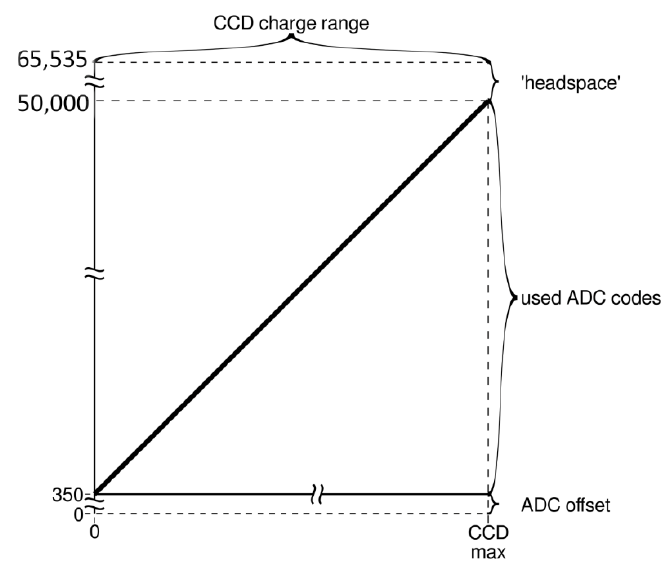
Figure 3. Diagram showing how all possible CCD output values (after amplification; X-axis) are mapped onto the value range of the analog-to-digital converter (ADC; Y-axis). As the zero value of